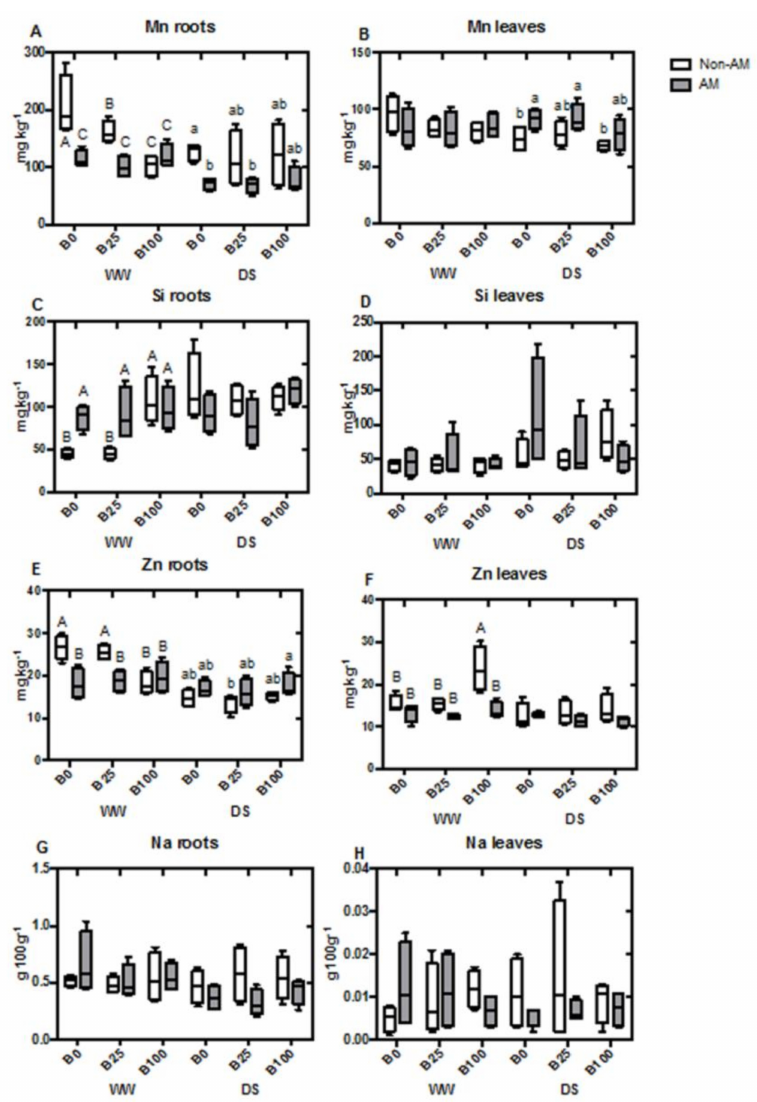
Figure 3. Boxplots representing root and leaf concentrations of Mn in roots ( A ) and in leaves ( B ), Si in roots ( C ) and in leaves ( D ), Zn in roots ( E ) and in leaves ( F )and Na in roots ( G ) and in leaves ( H ). Boxes represent the interquartile range, with the line representing the median, whiskers represent maxima and minima within 1.5 times the interquartile range. Di ff erent letters indicate significant di ff erences among treatments ( p < 0.05) based on Duncan’s